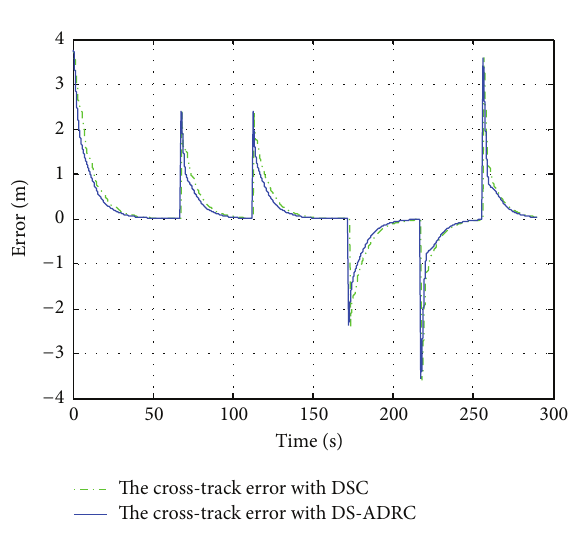
Figure 7: The output of